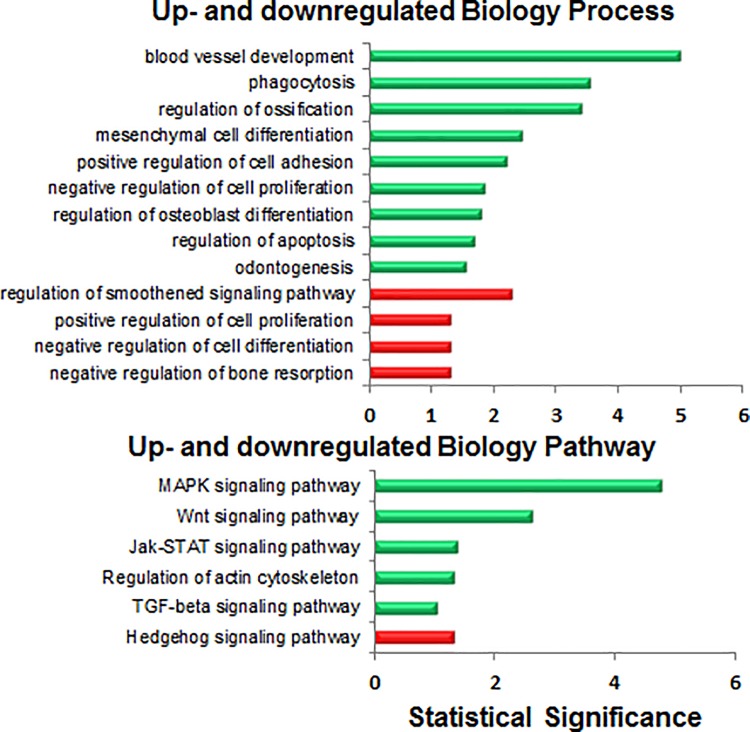
Unsupervised analysis of pathways and processes represented among GLI binding regions with differential gene expression.Publically accessed microarray data were overlapped onto identified GLI binding regions (containing at least one G1BR, G2BR, or GIS) and analyzed to identify 204 upregulated genes and 106 downregulated genes. Green = upregulated. Red = downregulated.